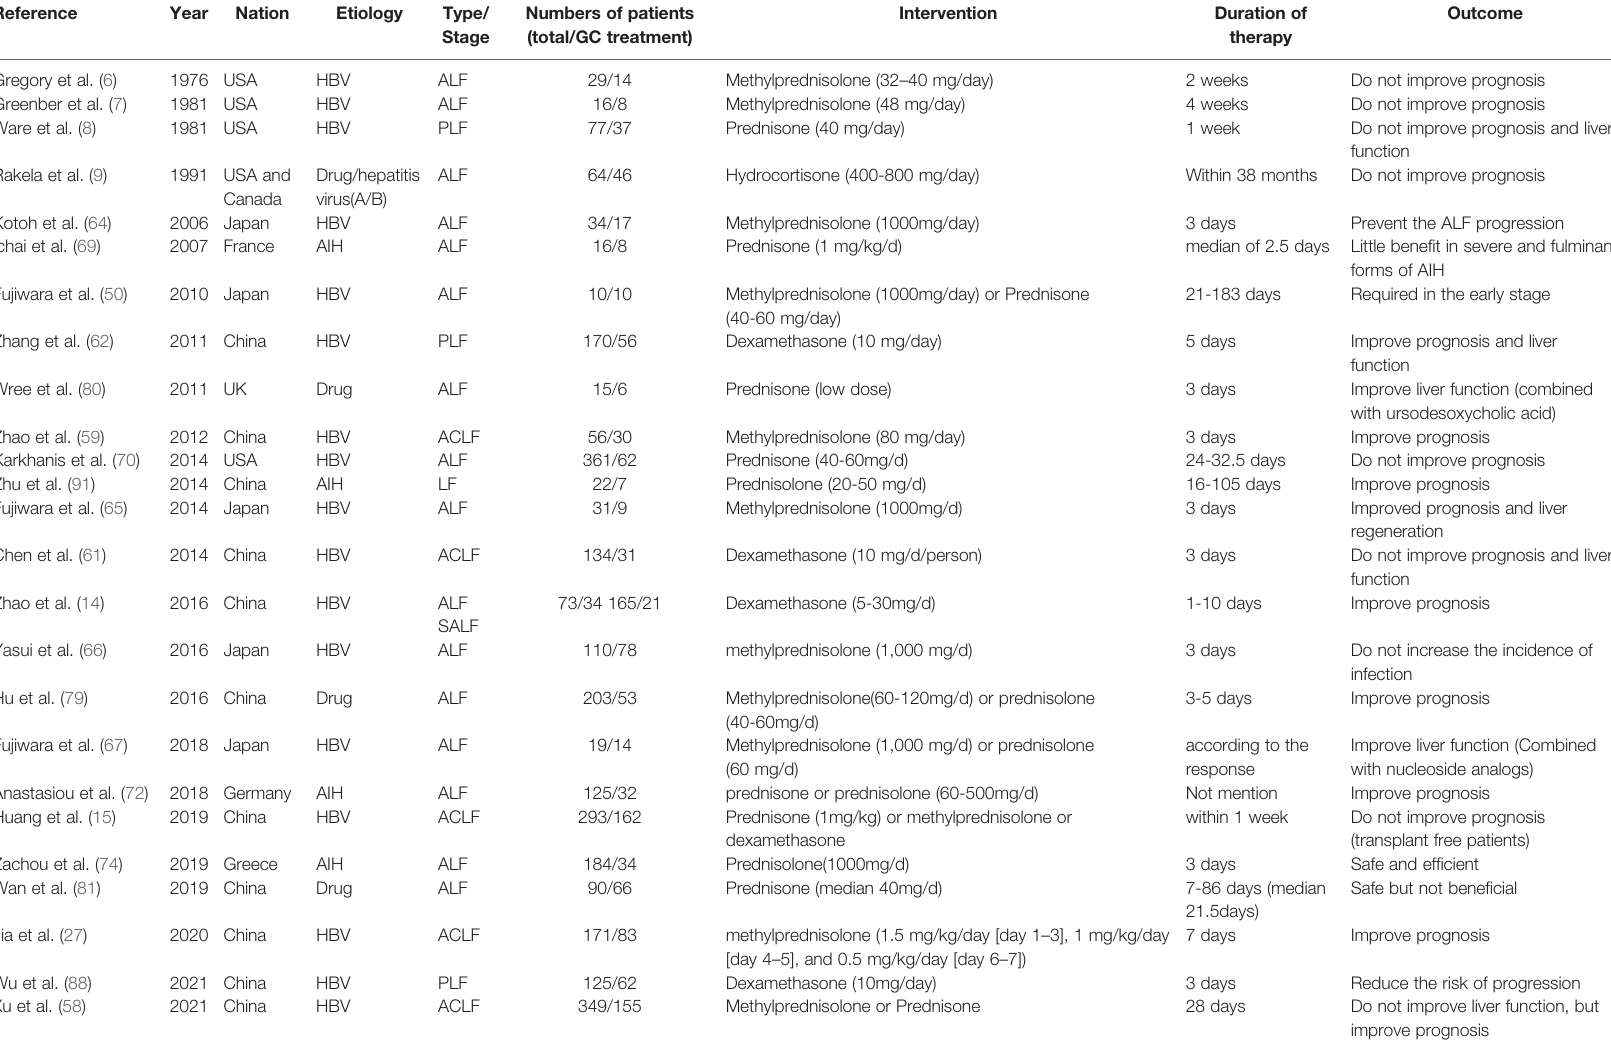
TABLE 1 | GC treatment in different etiology of liver